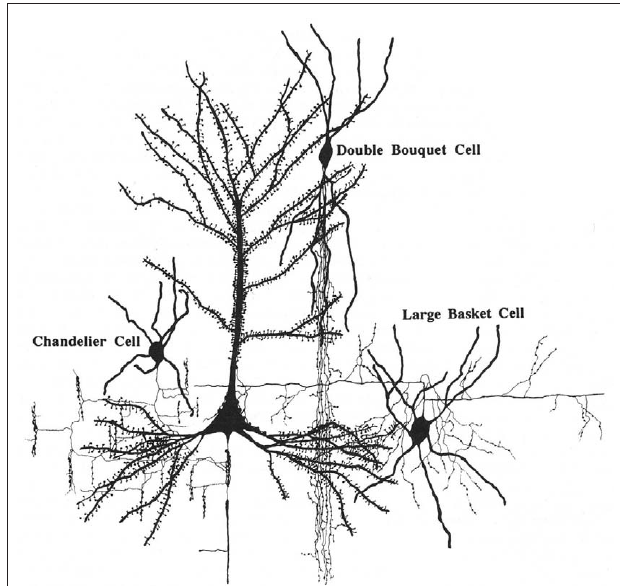
Figure 15 | Synaptic relationships between double bouquet cells, chandelier cells, and large basket cells with pyramidal cells. These cells constitute the best morphologically and chemically characterized types of interneurons. From DeFelipe and Fariñas (1992).